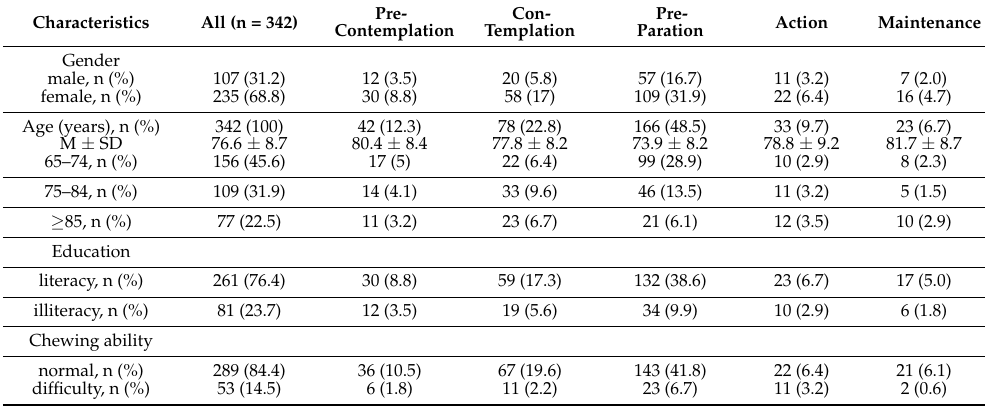
Table 2. Baseline characteristics of the study population, stratified by stages of change (n = 342).